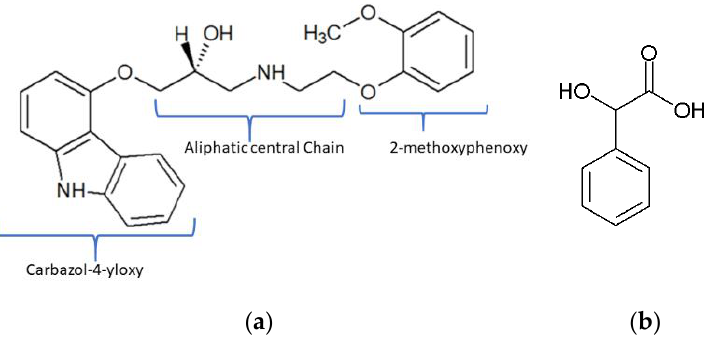
Figure 1. Structures of racemic carvedilol (CVD) (( a ), one enantiomer shown for clarity)) and DL-mandelic acid (DL-MA) ( b ).